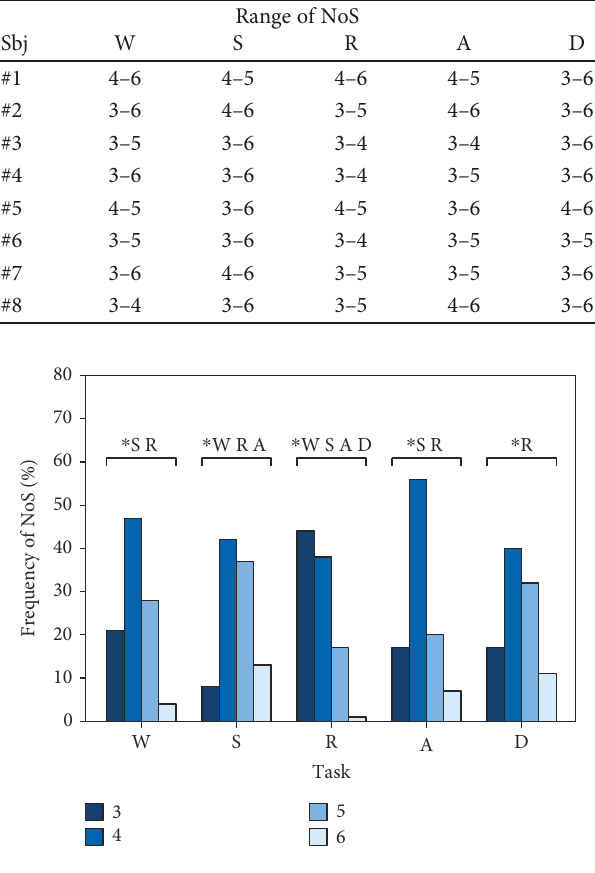
Figure 2: Frequency of occurrence of the synergy model for each daily life activities. ∗ stands for statistical di ff erences.